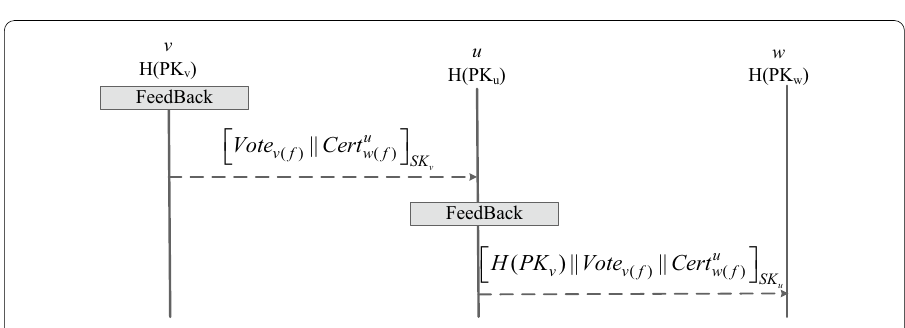
Fig. 5 Security protocol of evaluation feedback process. Node V carries the proof feedback source’s evaluation ticket to service F, and the proof transaction certificate of node U and node V. When node U continues to feedback to node W, the steps are similar to the evaluation collection, but this time it carries the evaluation ticket from V. The protocol guarantees that the identity of any process node will not be counterfeited and that no node will deny its own